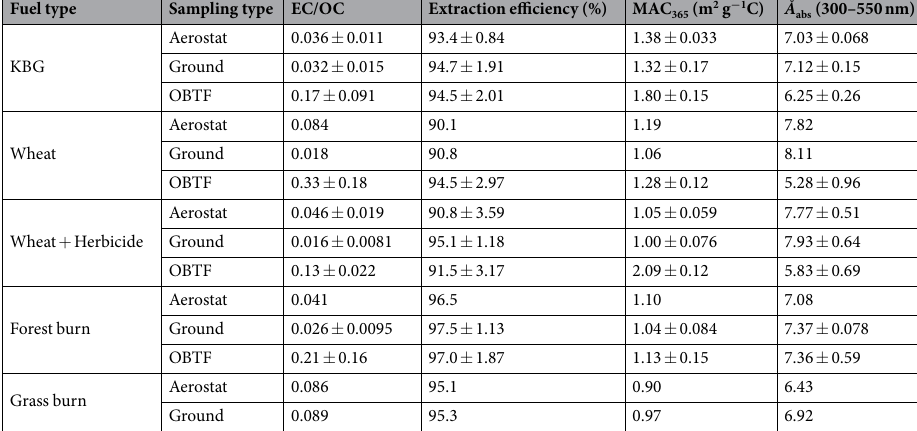
Table 2. EC/OC ratios, OC extraction efficiency and light absorption of organic aerosol from prescribed and laboratory